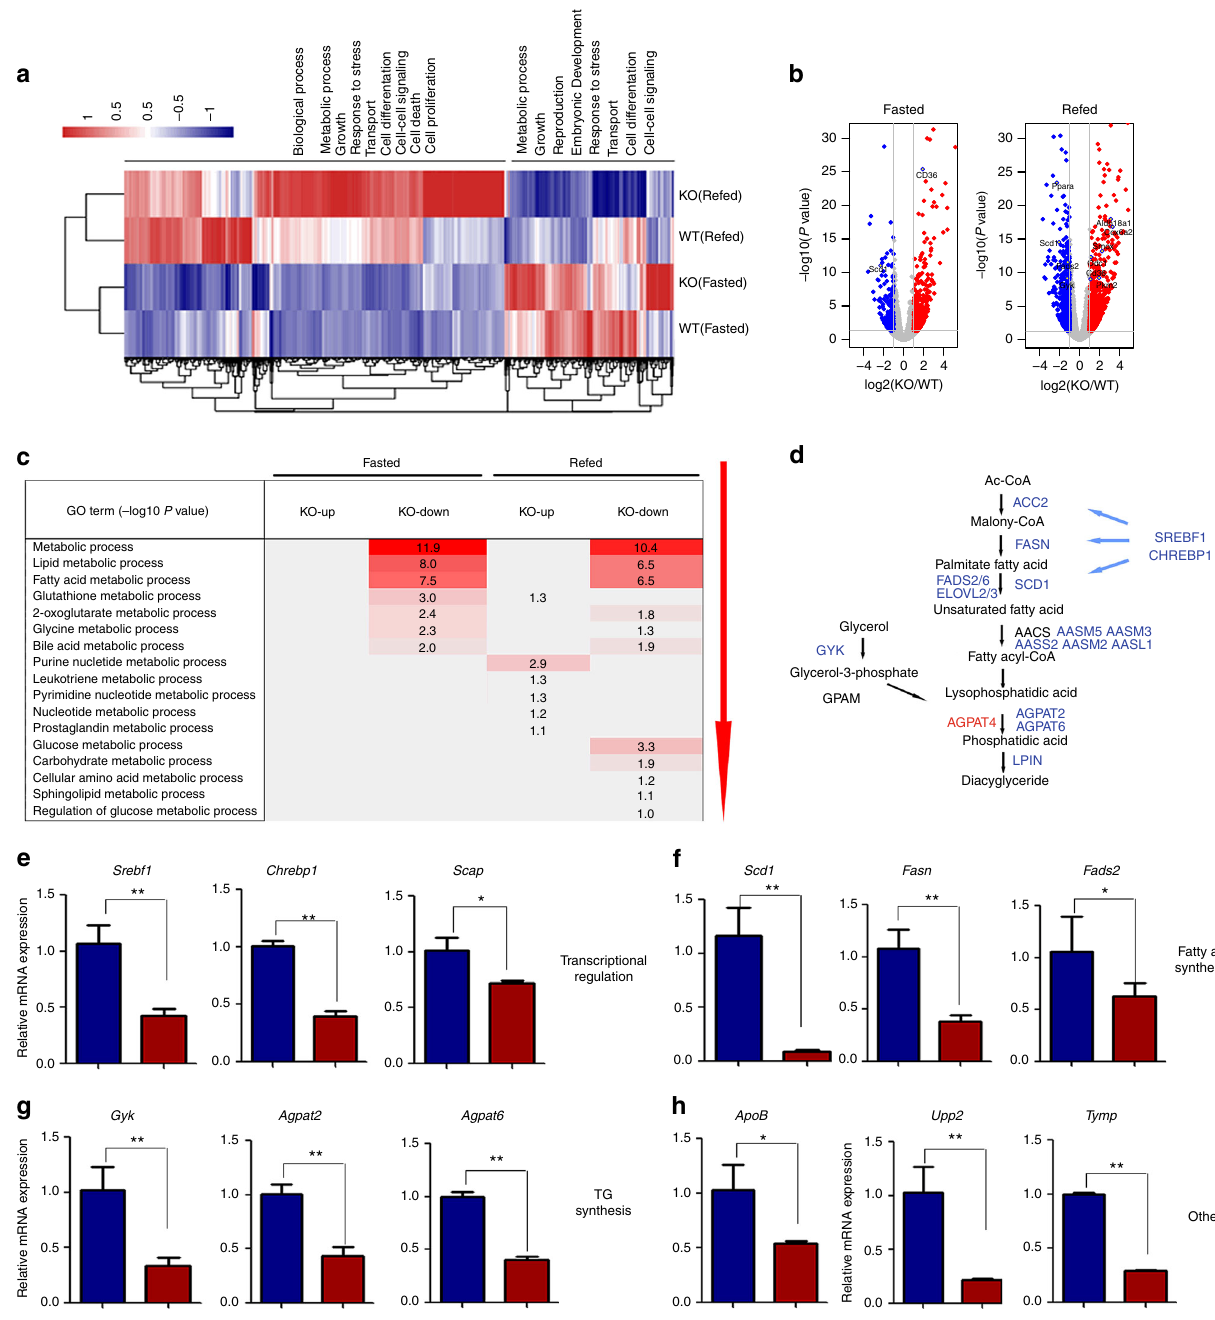
Fig. 5 HRD1 deletion reprograms liver metabolic gene expression pro fi les. a Heatmap of upregulated or downregulated hepatic genes from WT and HRD1 Alb mice. b Volcano plot of the genes from a under fasted and refed conditions. c Metabolic functions of the genes. d Key gene list related to metabolic function. e – h Hepatic gene expression pro fi les in WT and HRD1 Alb mice under the refed condition ( n = 6 for each group). The data are representative of three independent experiments (mean ± s.d.). * P < 0.05. ** P < 0.01 by unpaired Student ’ s t